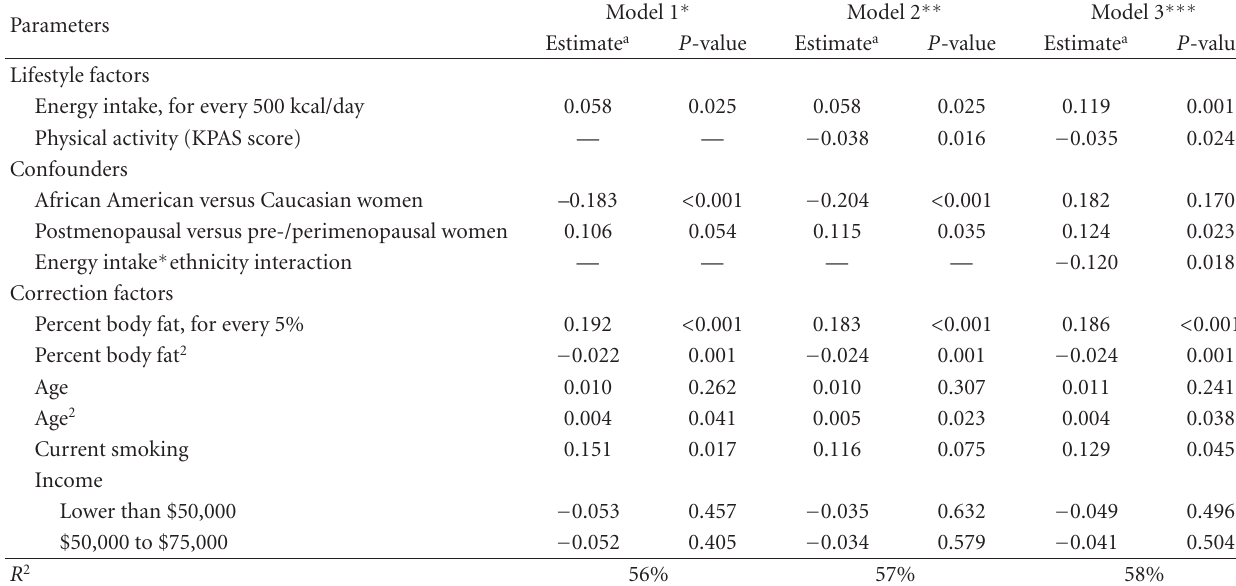
Table 2: Multivariable models of association between self-reported energy intake and intra-abdominal adipose tissue.